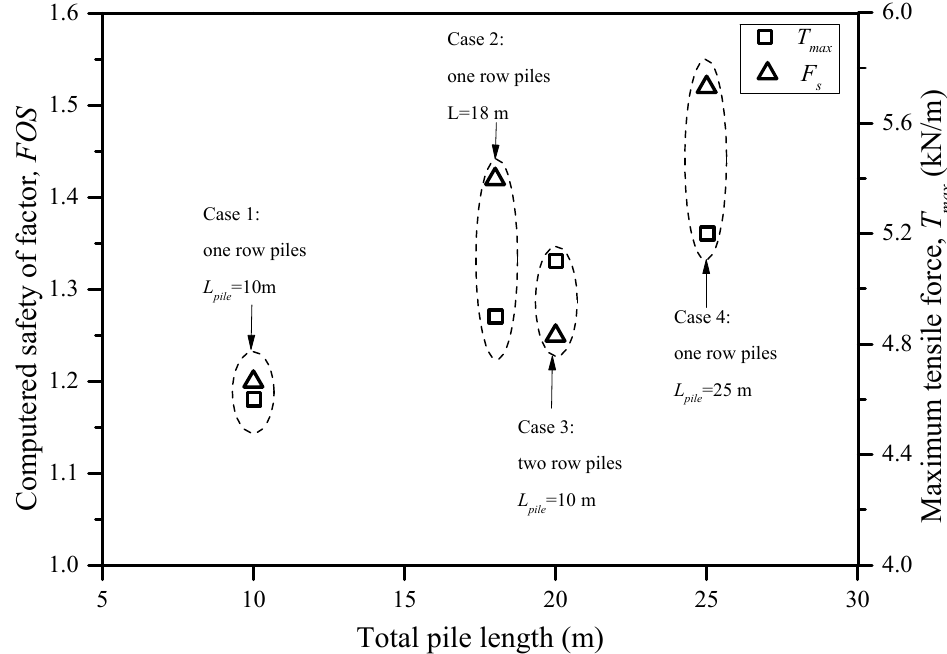
Figure 13. FOS and T max versus total pile length (m).